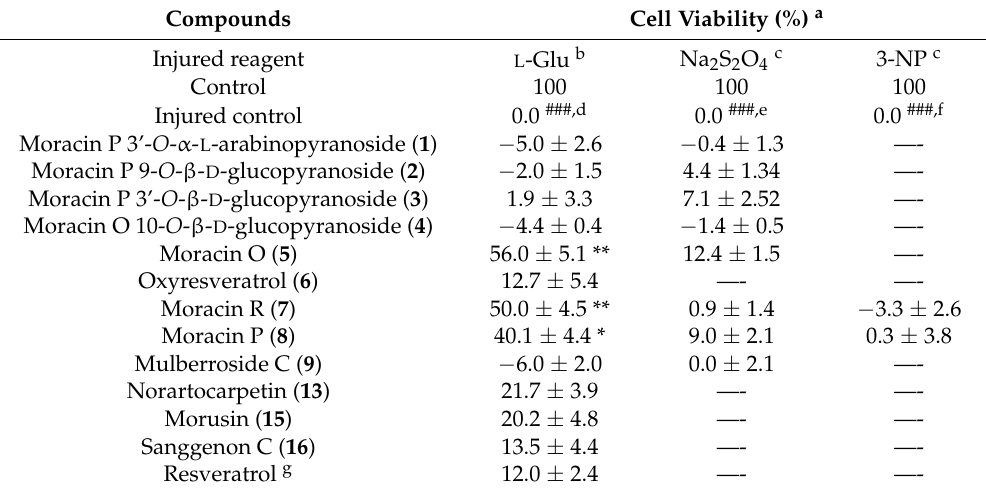
Table 3. Neuroprotective effects of compounds (10 µ M) from Cortex Mori Radicis against the injured neuron